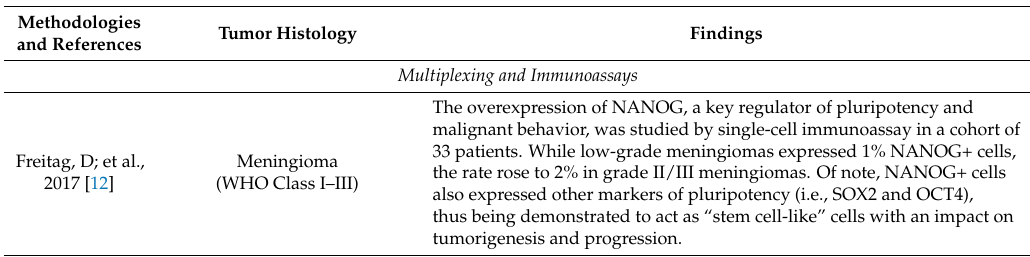
Table 3. Nanotech and Biomedical Engineering advances in Multiplexing and Immunoassays techniques for biomarkers in